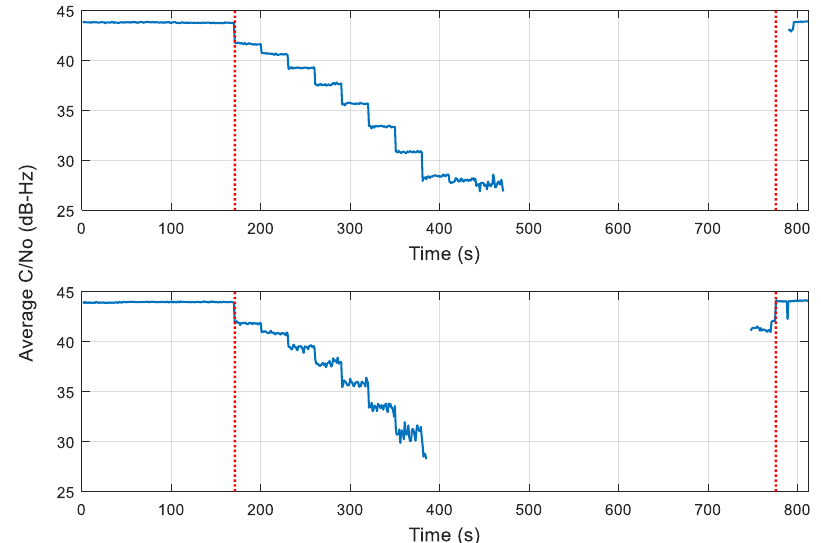
Figure 6. Average carrier-to-noise ratio of GPS constellation scenarios. ( Top figure )—narrowband interference; ( bottom figure )—wideband interference.